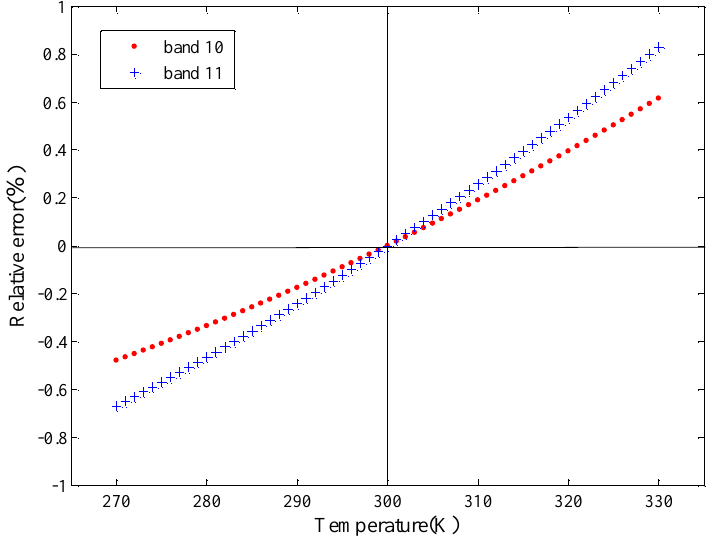
Figure 2. The relative error of the adjustment item which takes 300 K as a reference 𝑁 𝑗 (𝑇 𝑗 )−𝑁 𝑗 (300) ( ). 𝑁 𝑗 (300) Table 2. Comparisons between the Wien’s approximation and the modified Wien’s approximation. Relative Error between the Approximation and the True Value of B Temperature Wien’s Approximation Modified Wien’s Approximation T (3) − 5 −1.04/−1.59 (1) −0.04/−0.06 0 T −1.13/−1.70 −0.07/−0.11 0 T + 5 −1.21/−1.82 −0.10/−0.17 0 T + 10 −1.30/−1.95 −0.13/−0.23 0 T + 20 −1.50/−2.21 −0.21/−0.36 0 T + 30 −1.71/−2.48 −0.28/−0.49 0 Note: (1) For an example, −1.04/−1.59 means that the relative errors are about −1.04% for band 10 and −1.59% for band 11, respectively; (2) The relative error based on the Modified Wien’s approximation is the average value of simulation data from 96 laboratory emissivity spectra; (3) T 0 is the temperature at the first layer of the atmospheric